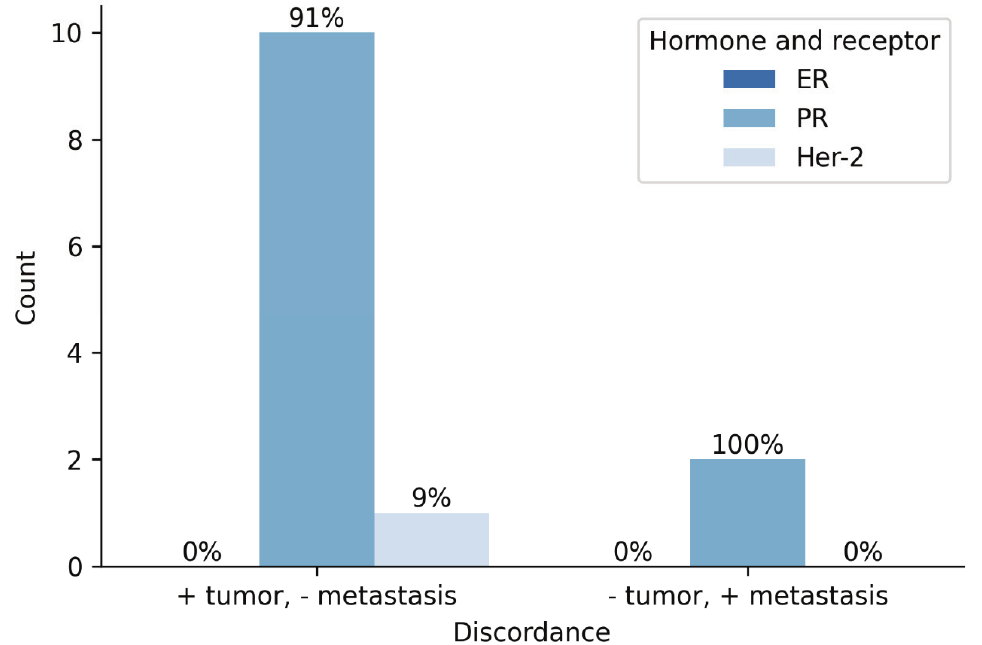
Figure 5. Status of hormone and Her2 receptors in primary tumor and